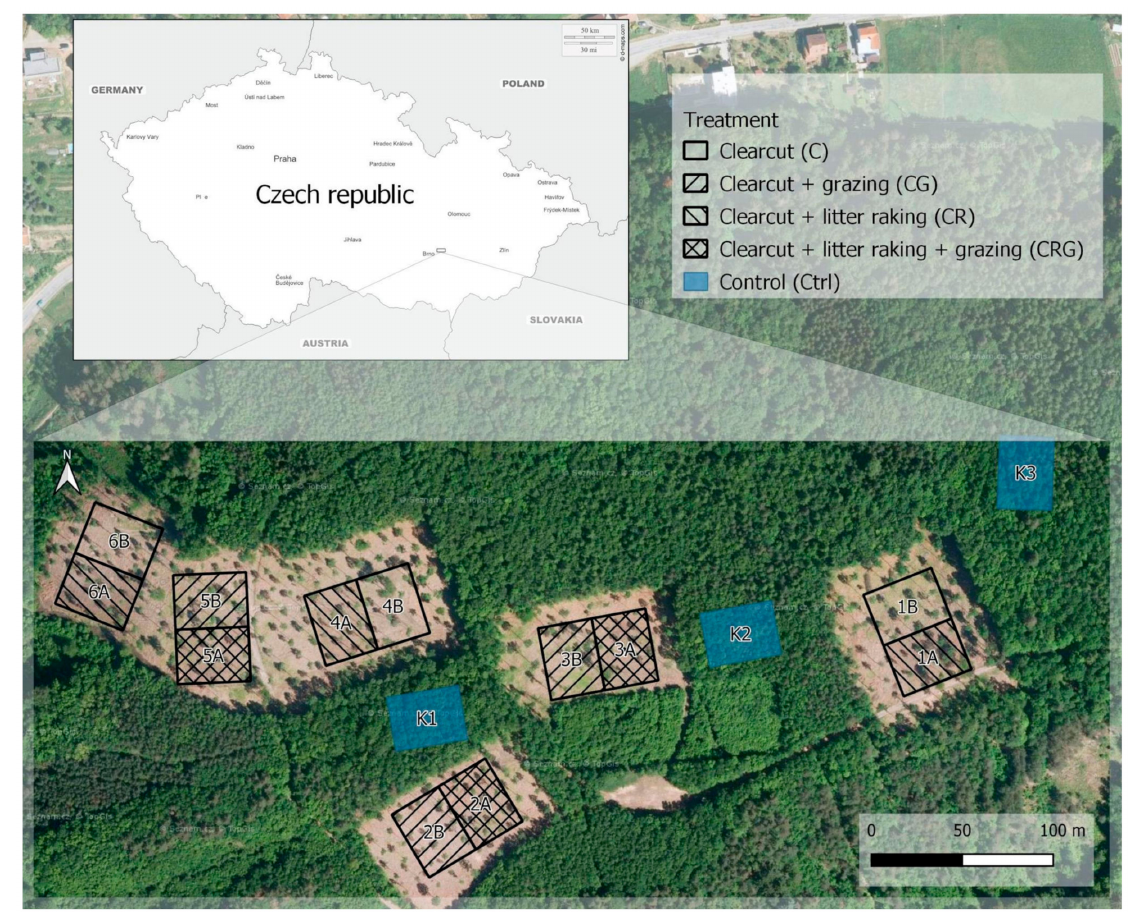
Figure 1. Location and distribution of the experimental plots, where 1B, 4B and 6B belong to treatment C; 1A, 4A and 6A belong to treatment CR; 2B, 3B and 5B belong to treatment CG; 2A, 3A and 5A belong to treatment CRG; and K1-K3 are control plots (Ctrl). (Orthophoto map © Seznam.cz, a.s., © TopGis,